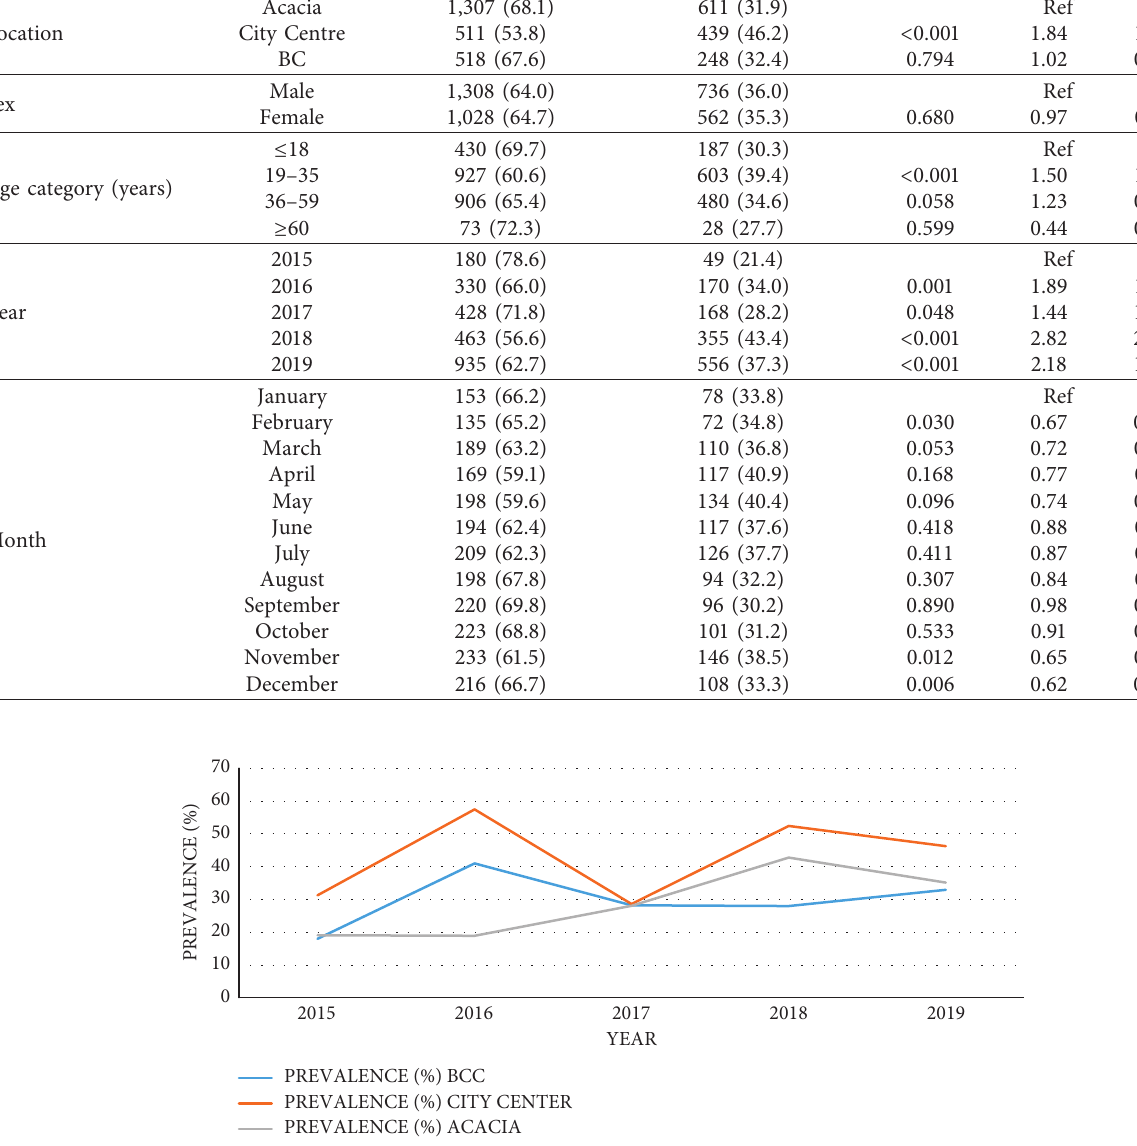
Figure 6: Clinic-specific annual trend of H . pylori infection